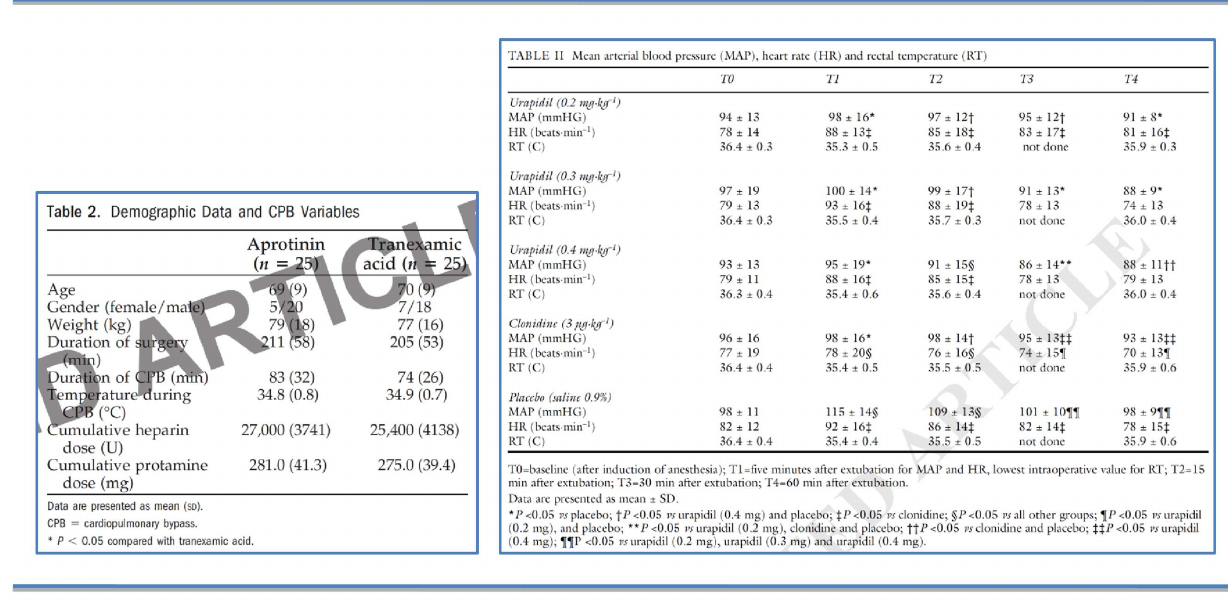
Figure 2. Transparent watermarks. Left panel: Anesthesia and Analgesia . Right panel: Canadian Journal of Anesthesia .